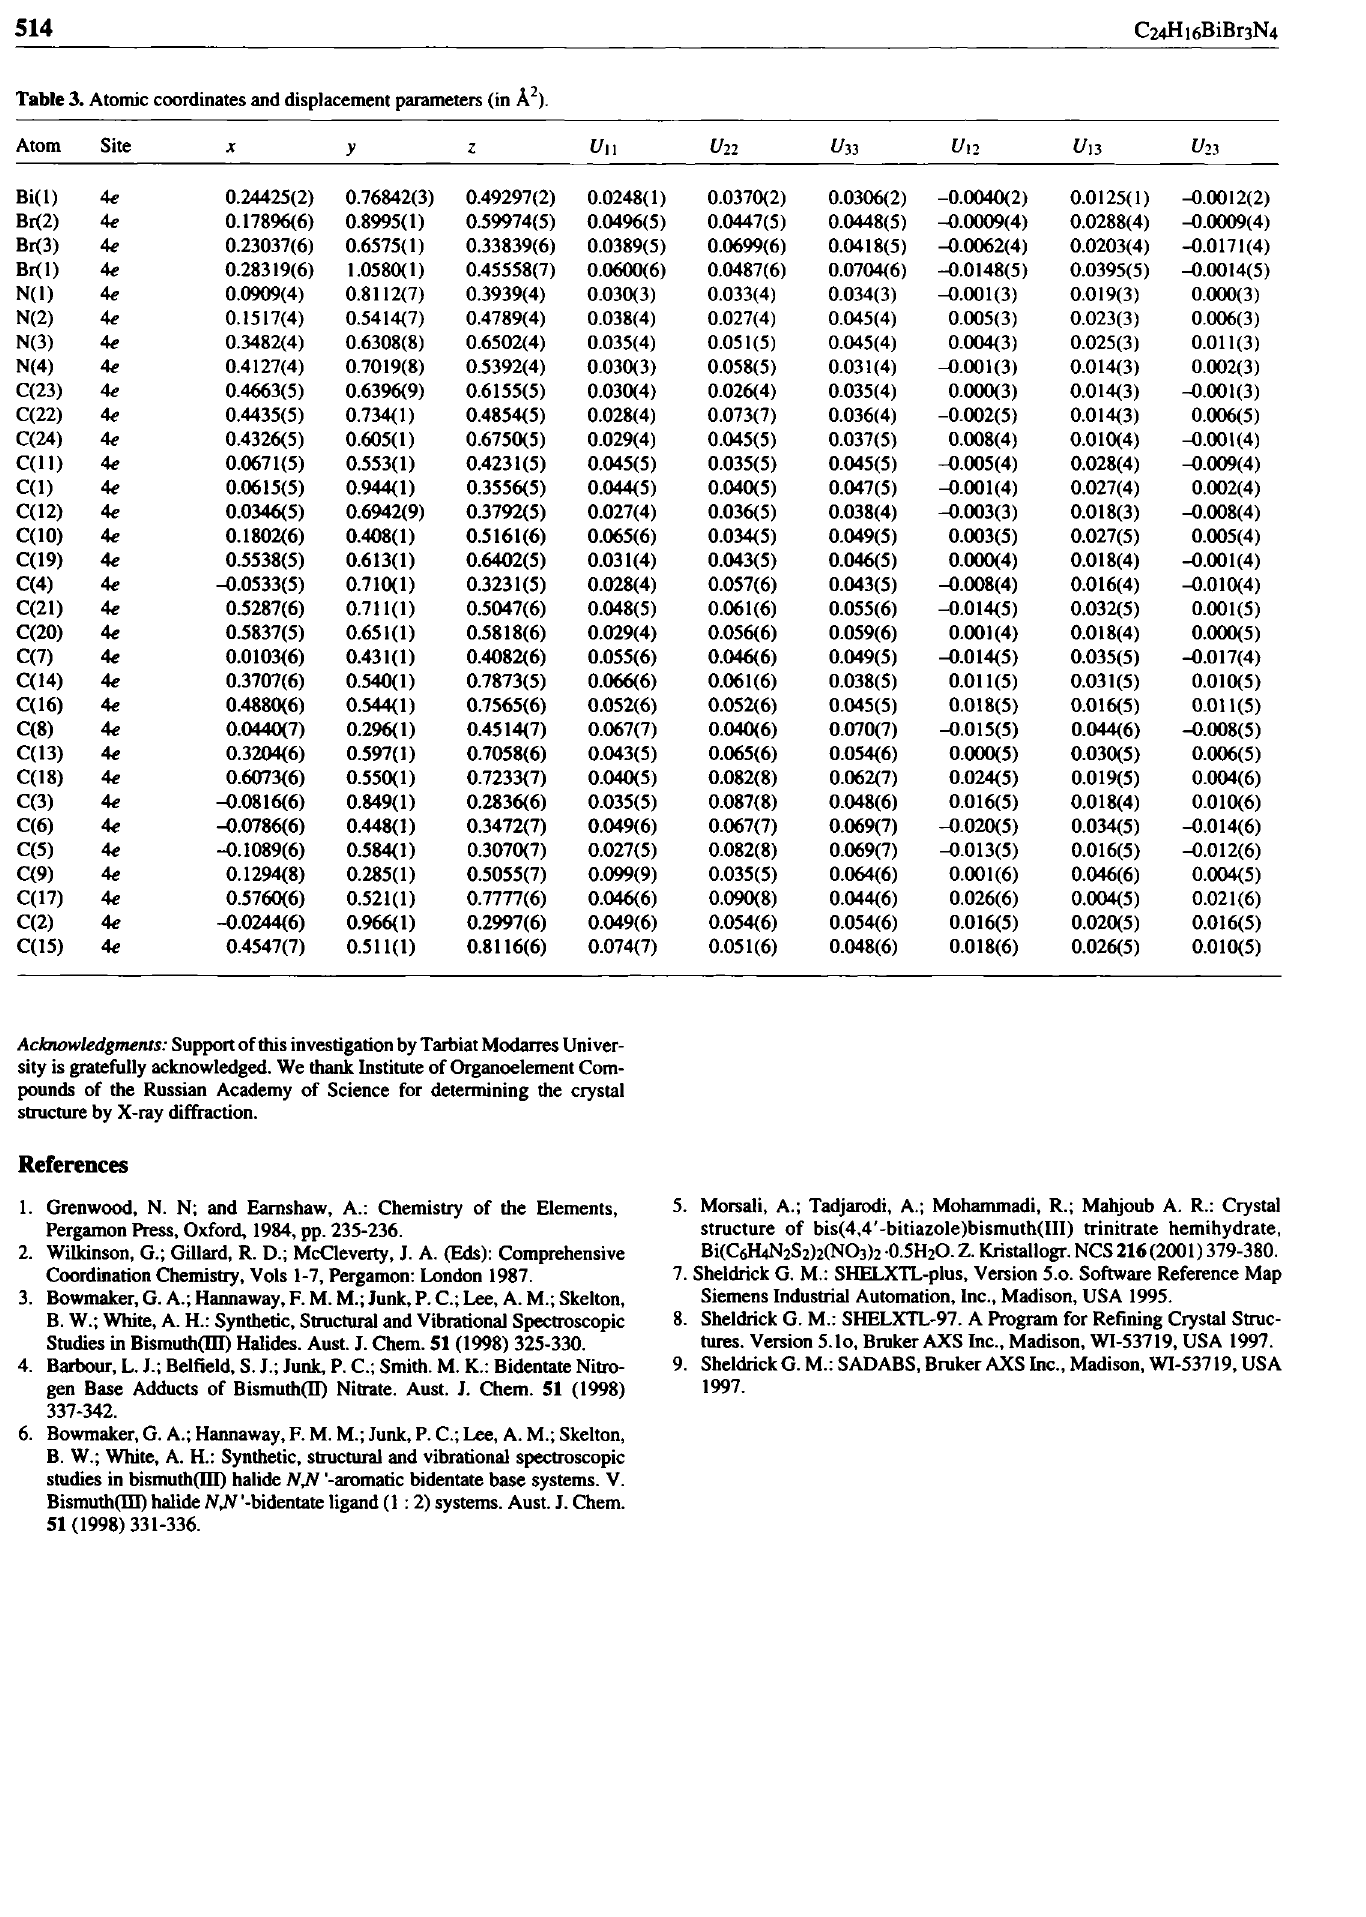
Table 3. Atomic coordinates and displacement parameters (in À 2